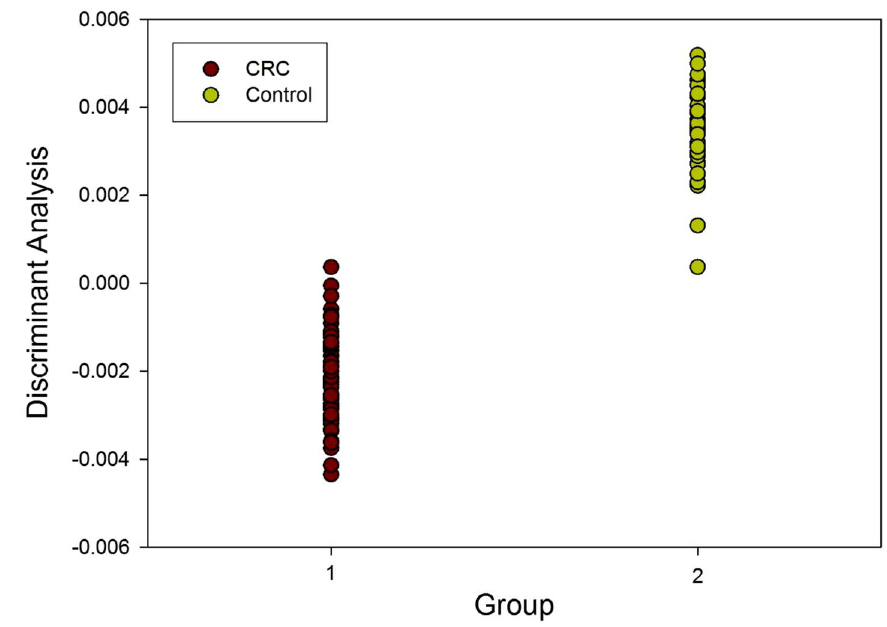
Figure 2. Fisher Disciminant Analysis (FDA) of FAIMS data in patients with CRC and controls.